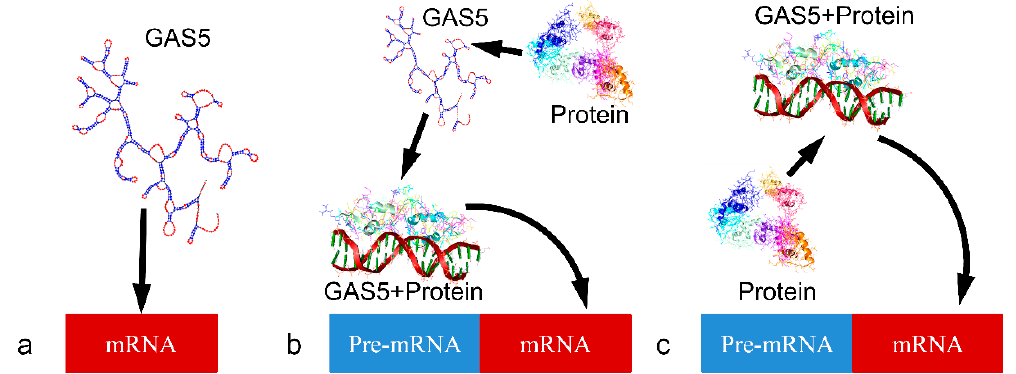
Figure 2. The three modes of action of GAS5 . ( b ) GAS5 acts directly on gene expression by regulating translation. ( a ) GAS5 acts indirectly on gene expression. This includes the formation of a GAS5 /protein complex regulating gene expression on the transcription level and finally again ( c ) indirectly through the formation of a GAS5 /protein complex, which acts as a post-transcriptional regulatory mechanism. (The diagram was adopted from [20]. Exemplary molecules presented include the crystal structure of the DNA-free Glucocorticoid Receptor DNA Binding Domain with reference no. 6CFN [21], which is depicted as “Protein” and the GAS5 /Protein complex is the crystallographic analysis of the interaction of the glucocorticoid receptor with DNA with reference no. 1R4R [22].)